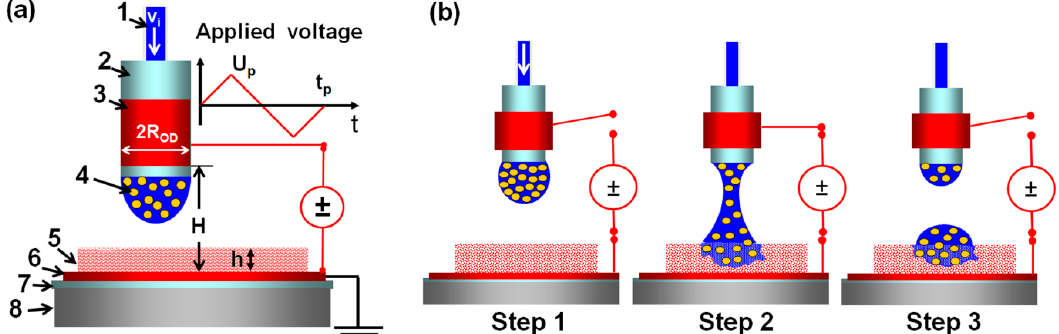
Figure 3. EHD DOD concept: ( a ) printing device: 1, infused fluid volume v i ; 2, insulating nozzle; 3, energized electrode; 4, suspension, 5, porous polymer film; 6, insulator; 7, ground electrode; 8, 3D-